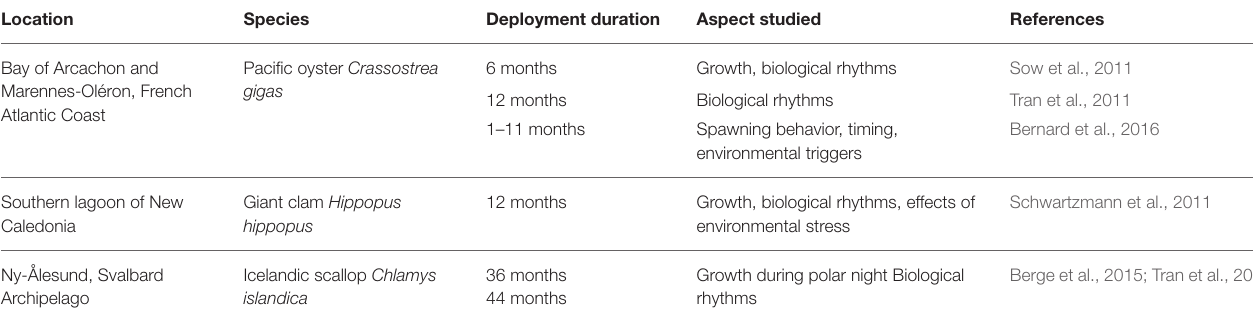
TABLE 1 | Field deployments of the HFNI valvometer (without in situ human intervention) as reported in peer-reviewed